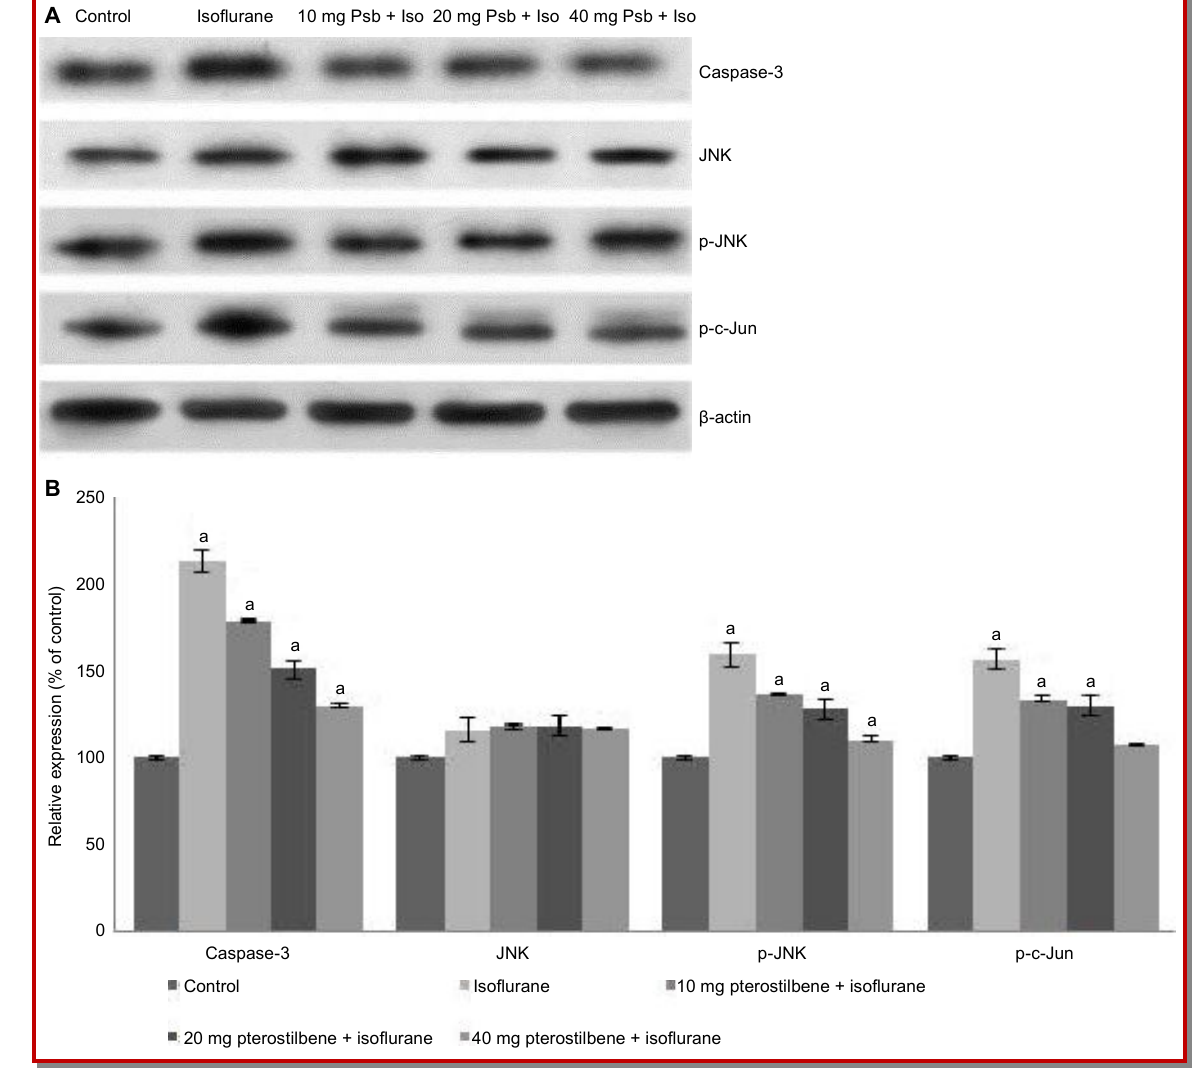
Figure 2 (A-D): Influence of pterostilbene on the expression of caspase -3, JNK and PI3/Akt pathway proteins C- Control; Iso-Isoflurane; Psb- Pterostilbene; Relative expression of caspase -3 and signalling pathway proteins (A and C). Values are represented as mean ±SD; n=6 (B and D); a represents statistical significance at p<0.05 compared against control as determined by one -way